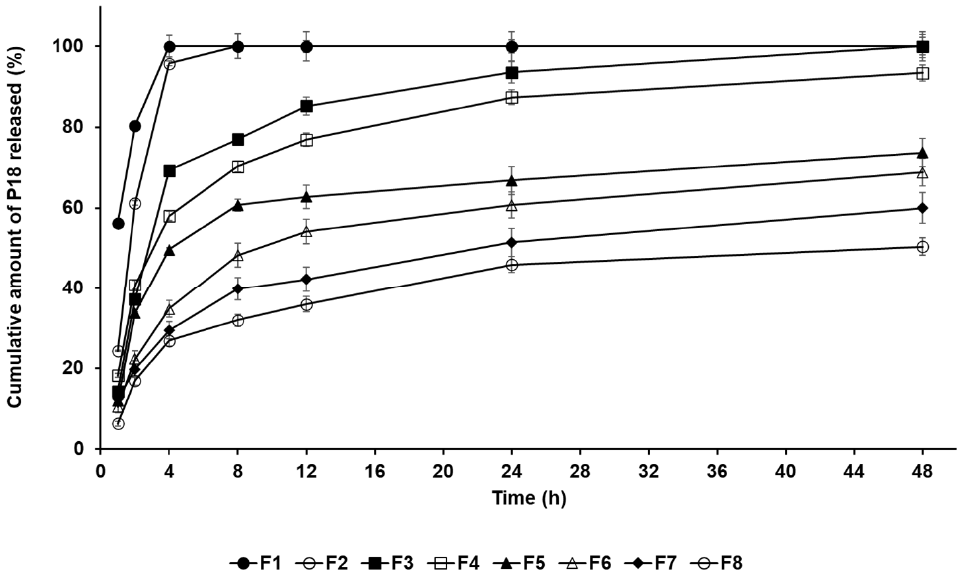
Figure 6. Cumulative percentage release profiles of P18 from SLNs F1–F8 in release medium, as determined using dialysis method. Results are expressed as the means ± standard deviations of three independent experiments ( n = 3).